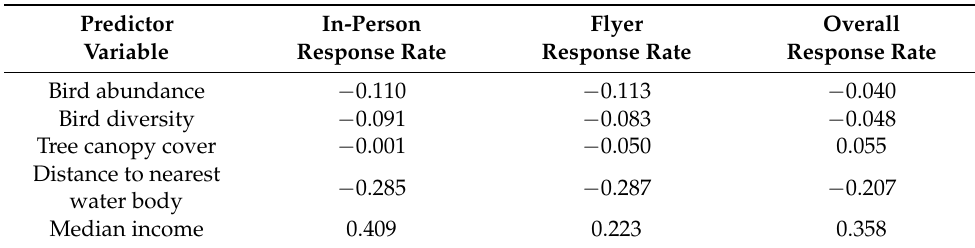
Table A1. Pearson correlation coefficients between predictor variables and response rates. Predictor variables measured include bird abundance and species diversity, tree canopy cover (ha), distance to water (km), and median individual yearly income. Sites were surveyed until either there were 10 participants or until there were no more residential addresses to visit. In-person response rate is the number of individuals in the site who participated in door-to-door surveys divided by the total number of people who were spoken to in that site. The flyer response rate is the number of individuals who responded to the flyer divided by the total number of flyers left at residences. The overall response rate is the total number of participants divided by the total number of people contacted (either in-person or by flyer) in each site.